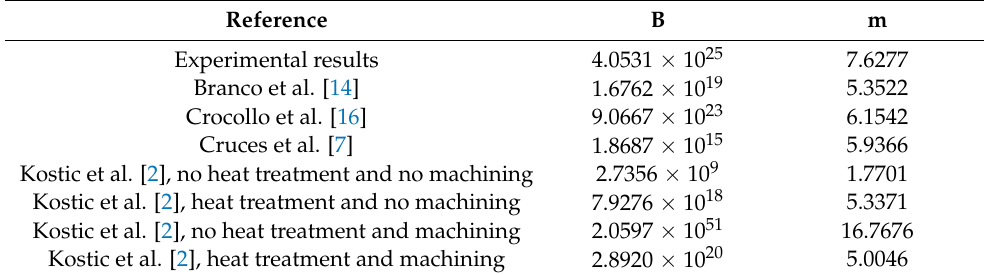
Figure 21. A combined reference mean and design fatigue curve on the basis of the tension–compression experimental and literature results presented in the previous section for the case of R = − 1 with no high temperature effects. Table 3. Fatigue test results under tension–compression loading and R = − 1.